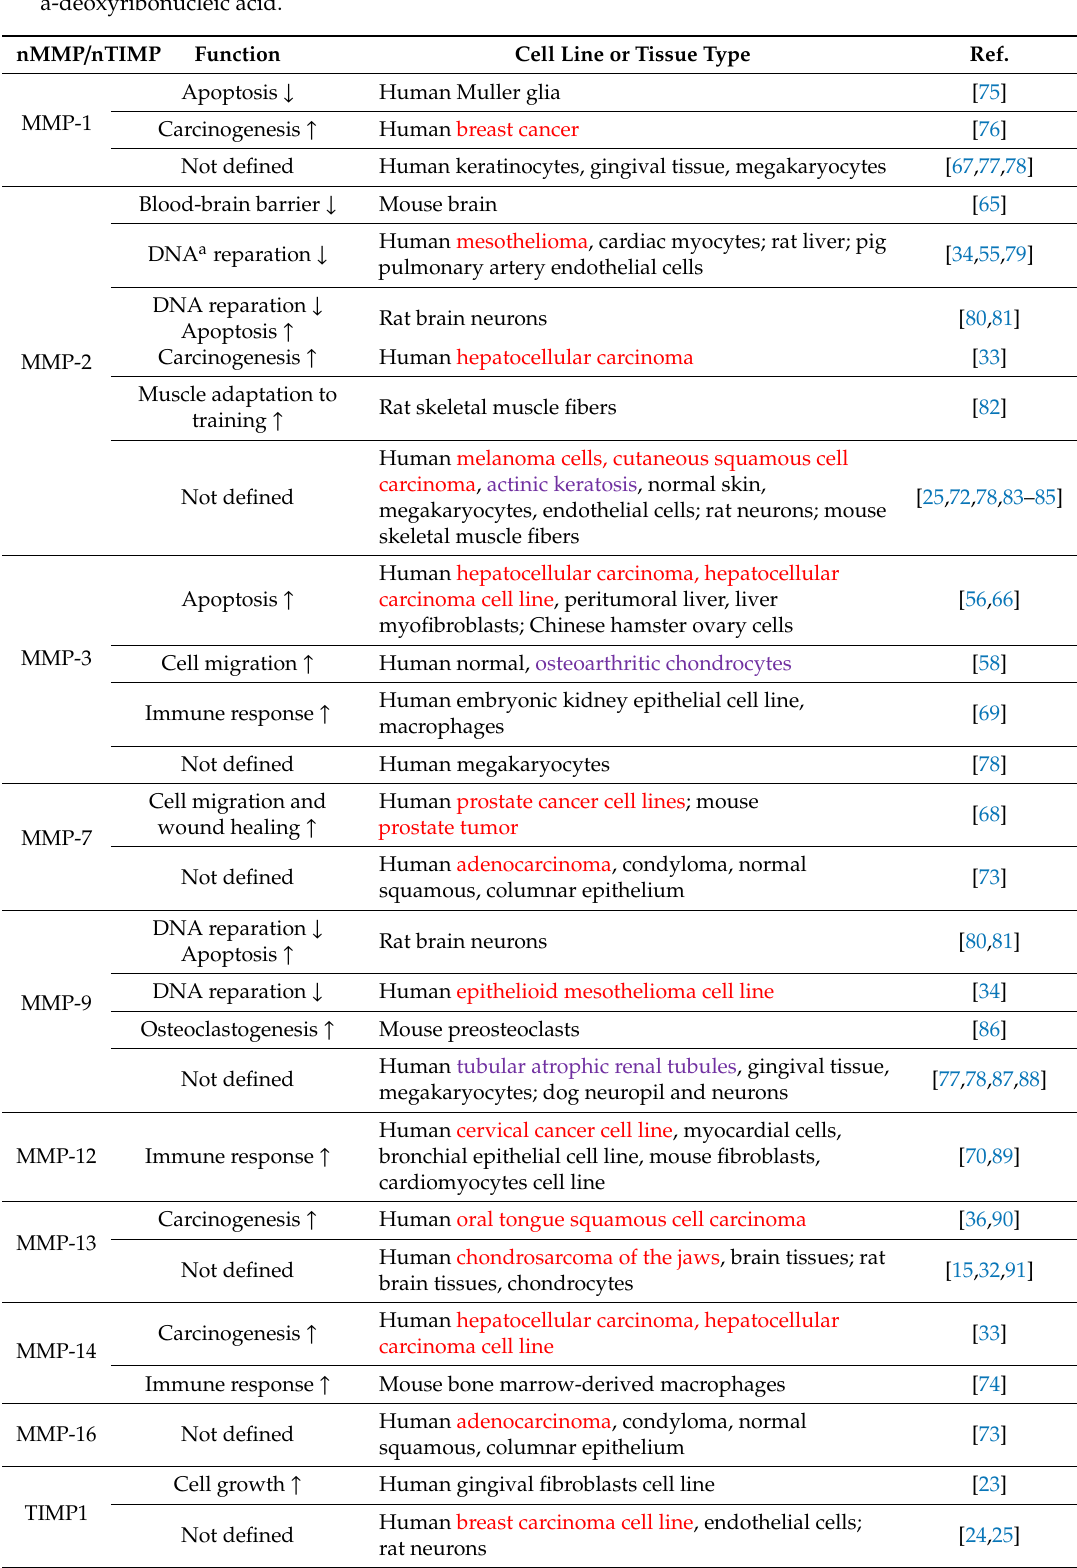
Table 1. Functions and localization of nuclear MMPs (nMMP) and nuclear TIMP (nTIMP). The table represents nMMPs and nTIMP1 and their functions in di ff erent cells and tissues. Malignant cells and tissues are indicated in red. Other pathological conditions are indicated in purple; a-deoxyribonucleic